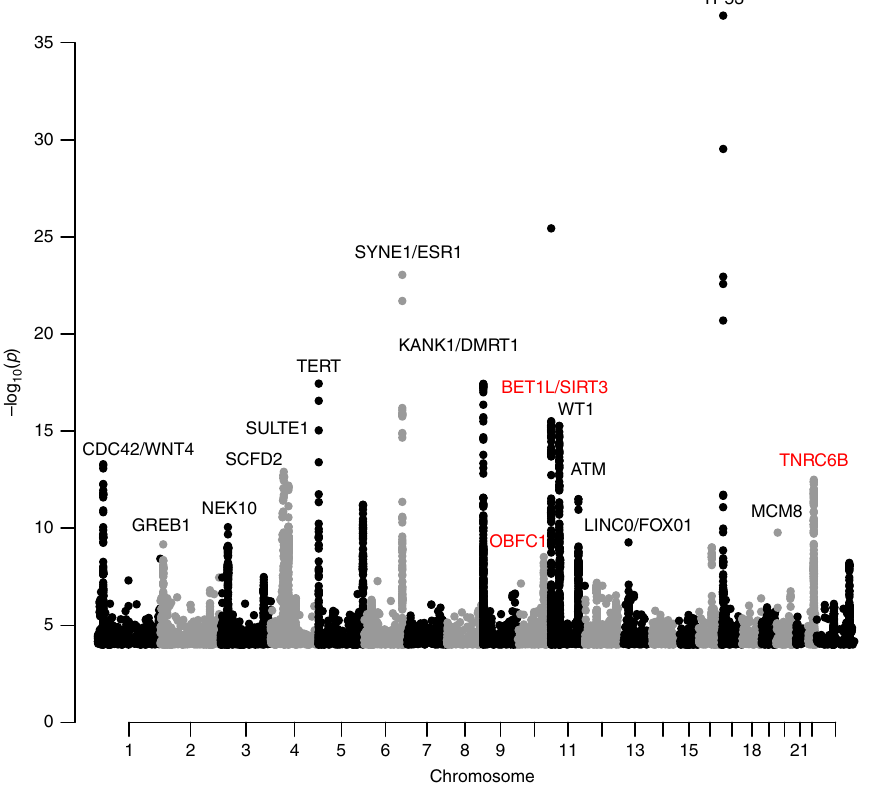
Fig. 1 Manhattan plot of the association results of meta-analysis of leiomyoma of the uterus. The Manhattan plot shows variants with P -value < 1.0 × 10 − 3 in a meta-analysis of GWAS data from 20,621 leiomyoma patients and 280,541 controls of European ancestry. Shown are negative log10-transformed P values ( y -axis) over 22 autosomes ( x -axis). Red font color indicates leiomyoma loci previously reported in the Japanese